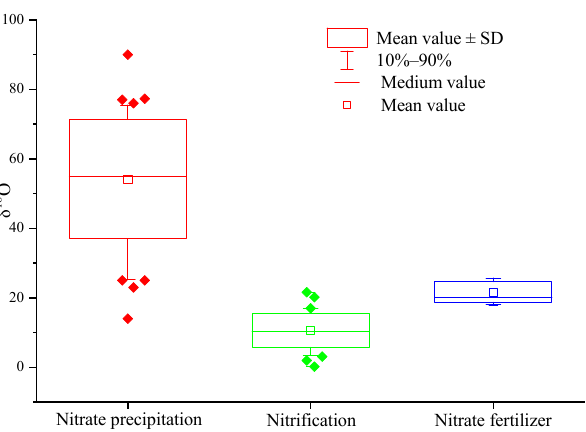
Figure 2. The box plots of δ 18 O values of NO 3 − from different sources. Note: (1) data source: literature [59–71,77–81], sample number: atmospheric deposition NO 3 − : n = 40; nitrification: n = 36; NO 3 − fertilizer: n = 15.